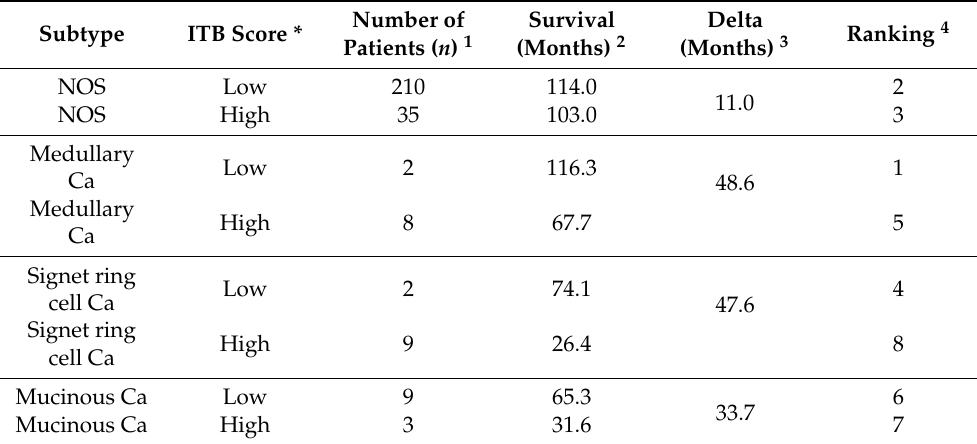
Table 3. ITB scores depending on histological subtypes and a comparison regarding metastasis-free survival